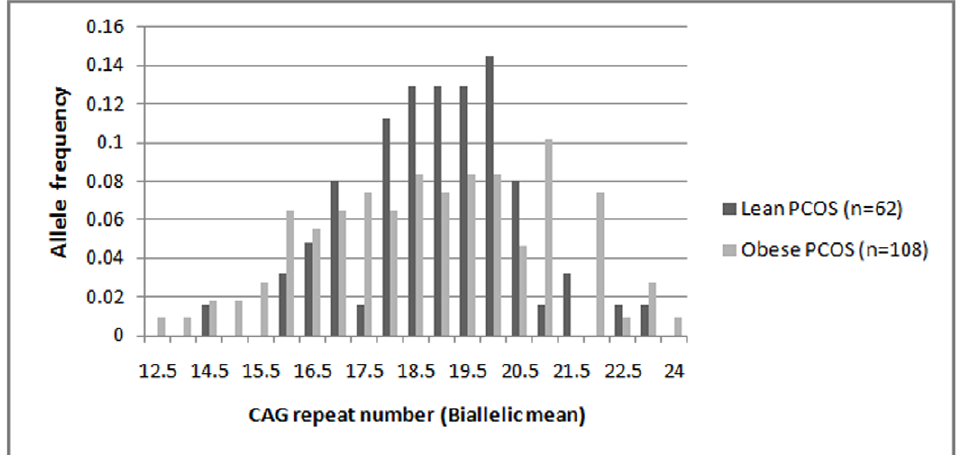
Figure 2. Distribution of CAG biallelic mean among Lean and Obese PCOS cases. doi:10.1371/journal.pone.0012401.g002 PLoS ONE |